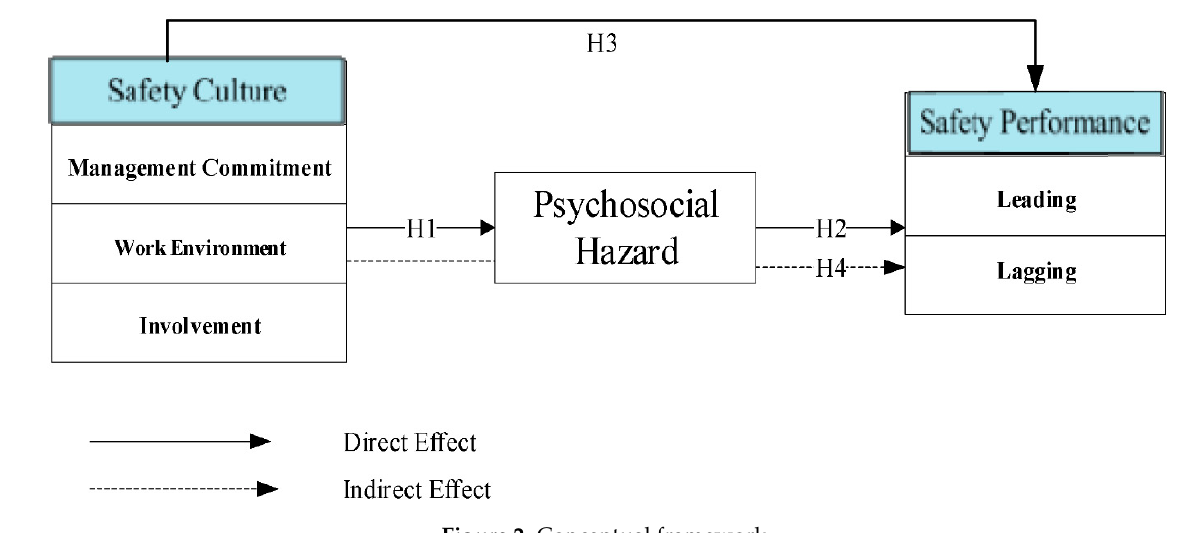
Figure 2 . Conceptual framework . Figure 2. Conceptual